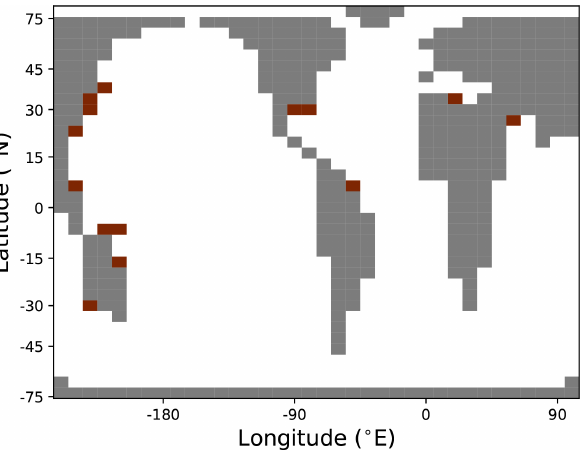
Figure D1. Locations with prescribed benthic carbonate deposi- tion representing carbonate reefs. Reef grid cells are highlighted in